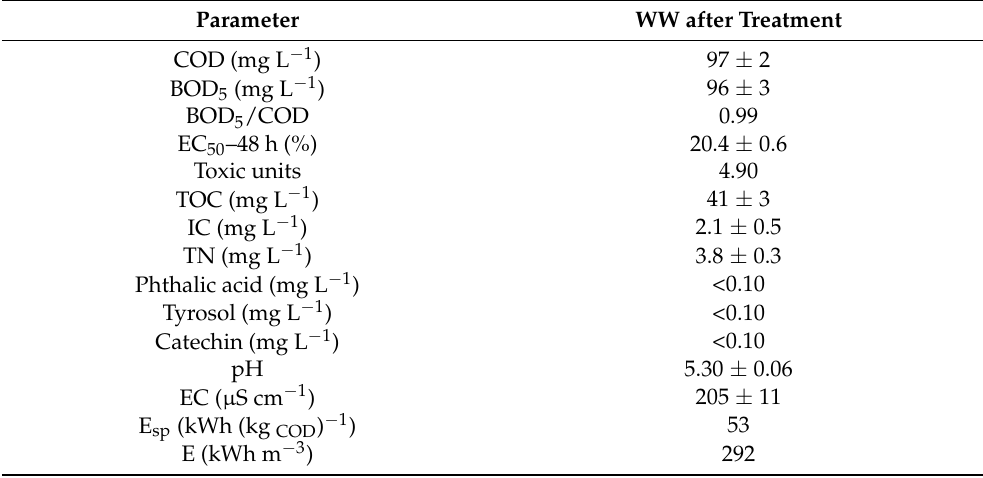
Table 3. Characterization of winery wastewater treated by EO, at 300 A m − 2 for 14 h, and energy consumption attained by the treatment.